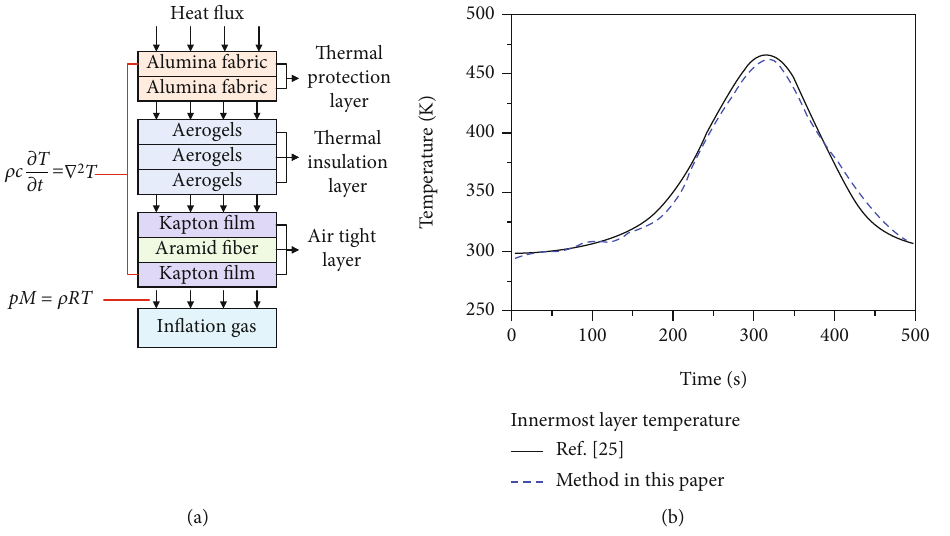
Figure 7: Model of thermal protection system and veri fi cation: (a) TPS model; (b) Table 1: Flight conditions.